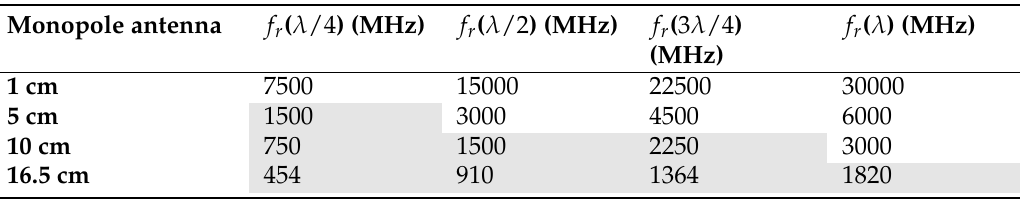
Table 1. Theoretical resonance frequencies for monopole